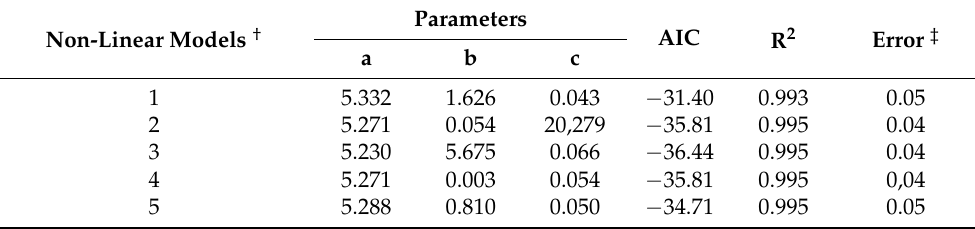
Table 5. Estimated biological parameters, values of Akaike’s information criterion (AIC), coefficient of determination, and absolute error of the adjusted models for the estimation of manure production in the growing–finishing phase, according to the pigs’ body weight.